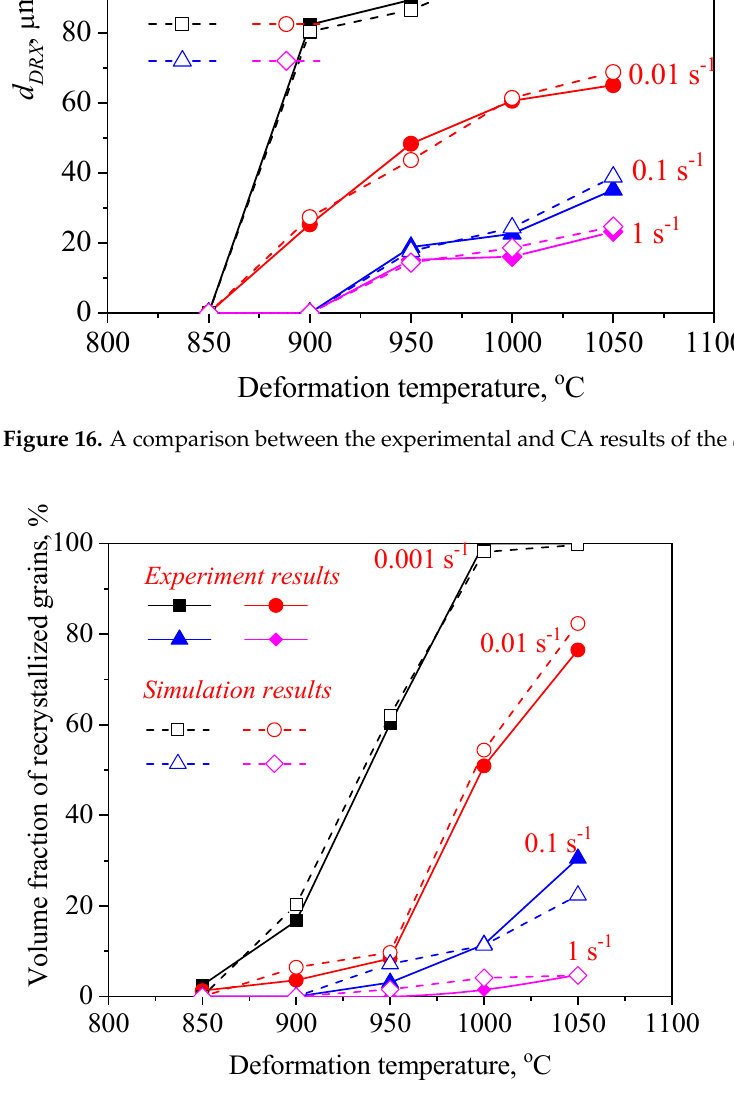
Figure 17. A comparison between the experimental and CA simulation results of the X DRX